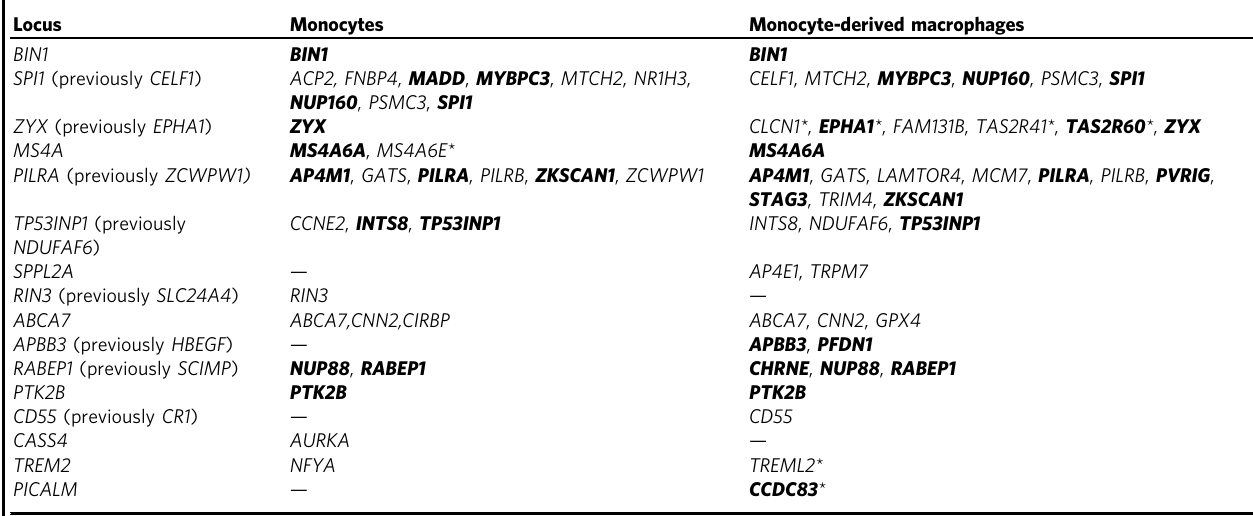
Table 1 Candidate causal genes identi fi ed through integration of AD GWAS signals with myeloid active enhancer annotations, promoter-capture Hi – C, and eQTLs